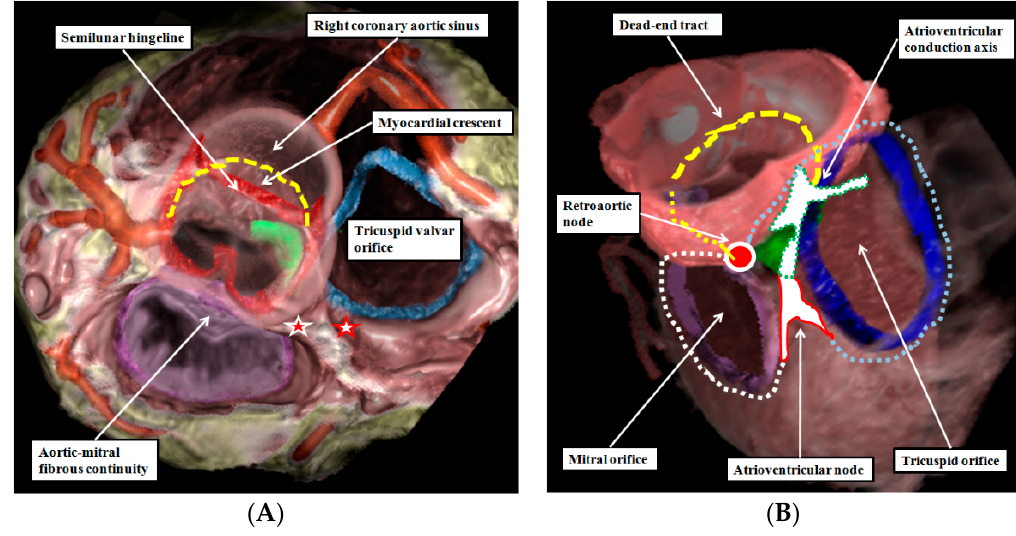
Figure 5. The images are taken from a dataset prepared from a patient undergoing investigation for coronary arterial disease using multi-detector computed tomography. The dataset has been reconstructed to show the semilunar hingelines of the aortic valve in red, the annulus of the tricuspid valve in blue, and the location of the membranous septum in green. The reconstruction is viewed from the cranial aspect in the left hand panel ( A ), with the left side of the heart seen to the left hand of the observer. The location of the dead-end tract is marked by the yellow dashed line. The white star with red borders shows the location of the atrioventricular node, while the red star with white borders shows the location of the retroaortic node. The right hand panel ( B ) shows the same reconstruction viewed obliquely from above and from the right. In this view, the location of the atrioventricular node is shown by the while area with red borders, with the atrioventricular conduction axis shown as the white area with dotted green borders. The tricuspid ring is shown by the blue dotted line, and the mitral ring by the yellow dotted line. The dead-end tract is again shown by the yellow dashed line, with the “missing” part of the initial interventricular ring in the area of aortic-to-mitral fibrous continuity shown by the dotted yellow line. The view of the reconstruction in the right hand panel shows how the atrioventricular node and the retroaortic node, shown by the red circle with white borders, are formed at the intersections of the atrioventricular and interventricular